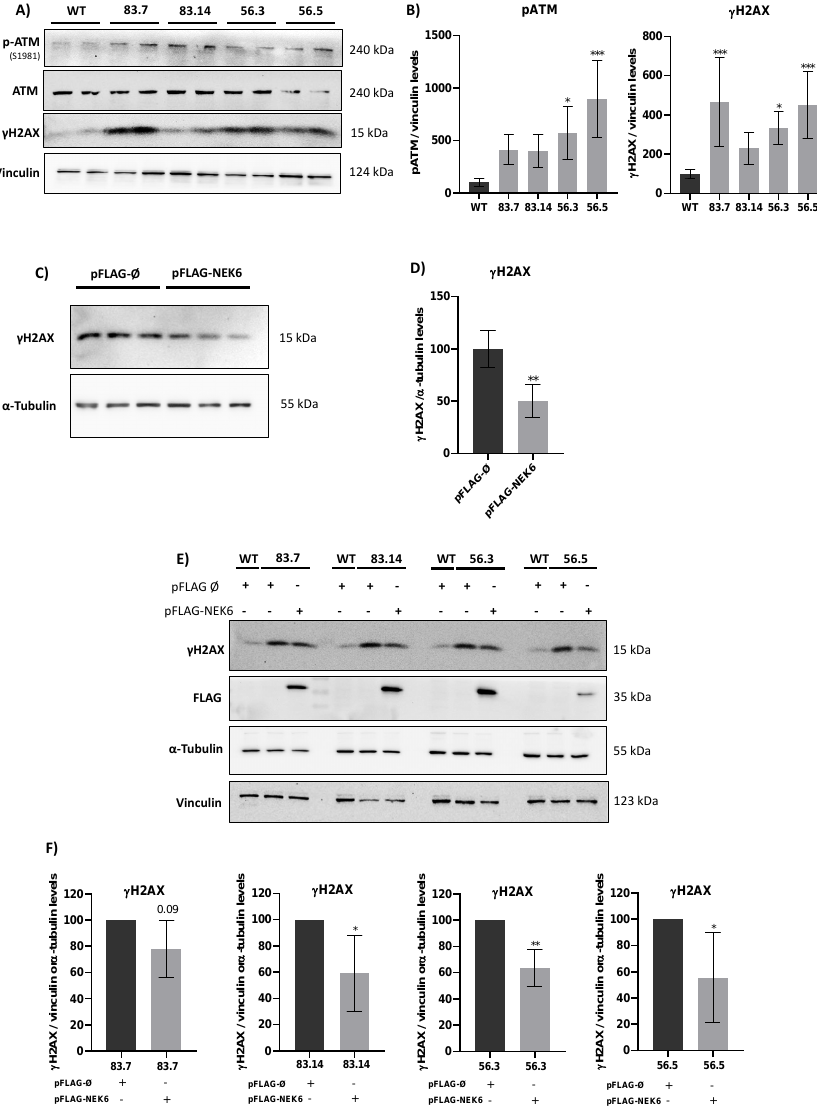
Figure 4. NEK6-KO increases DNA damage response in DU-145 cells. ( A ) NEK6-KO showed an increase in the phosphorylation of DNA damage markers, such as ATM and H2AX. ( B )